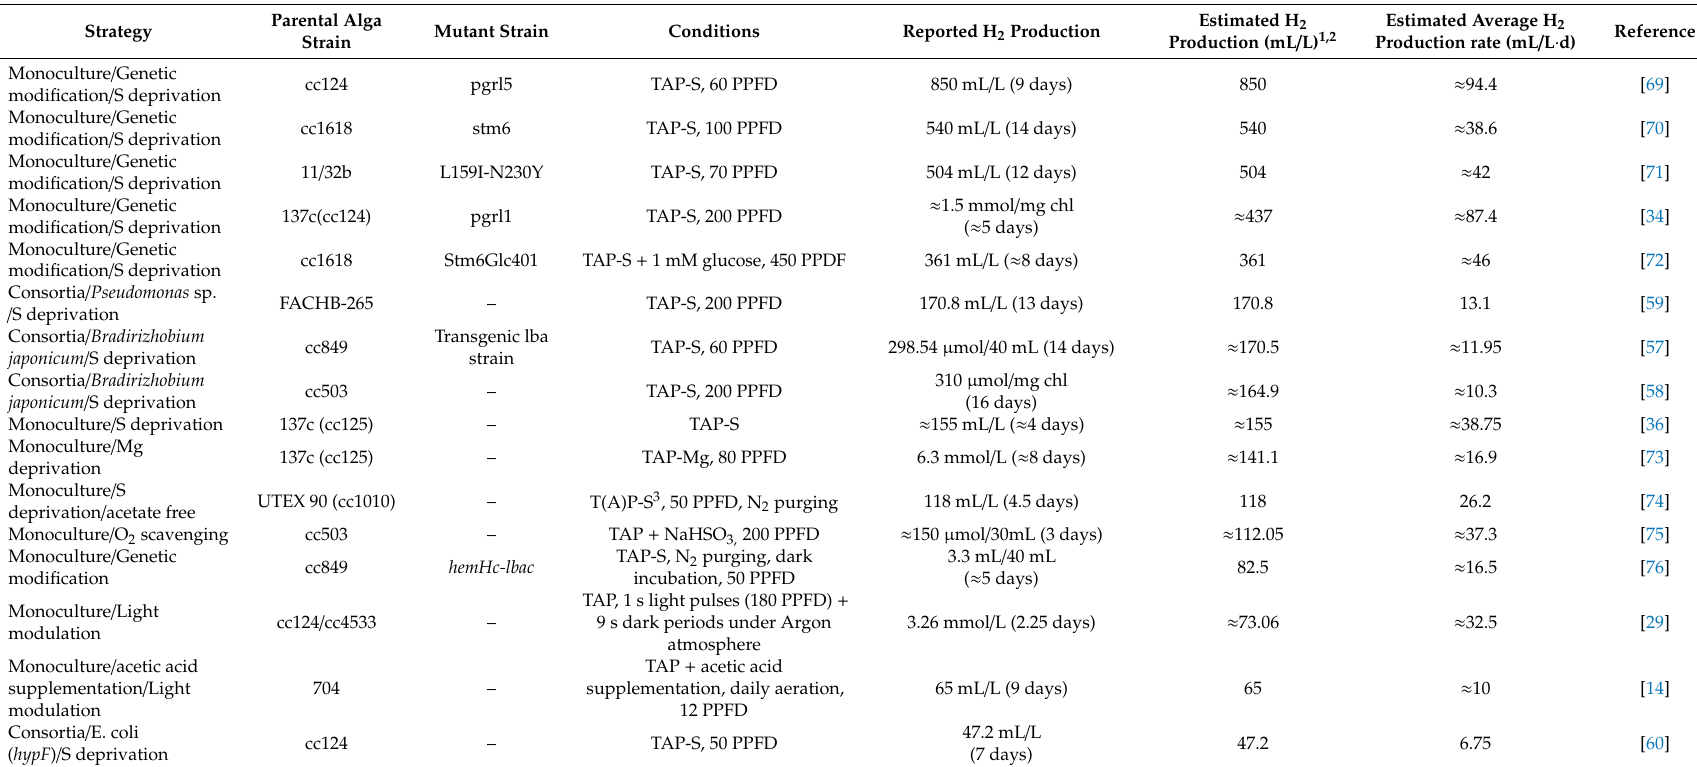
Table 2. Maximum H 2 productivity achieved by Chlamydomonas using di ff erent approaches. Data are ranked according to the total H 2 production yield. For each study, only the maximum reported values are